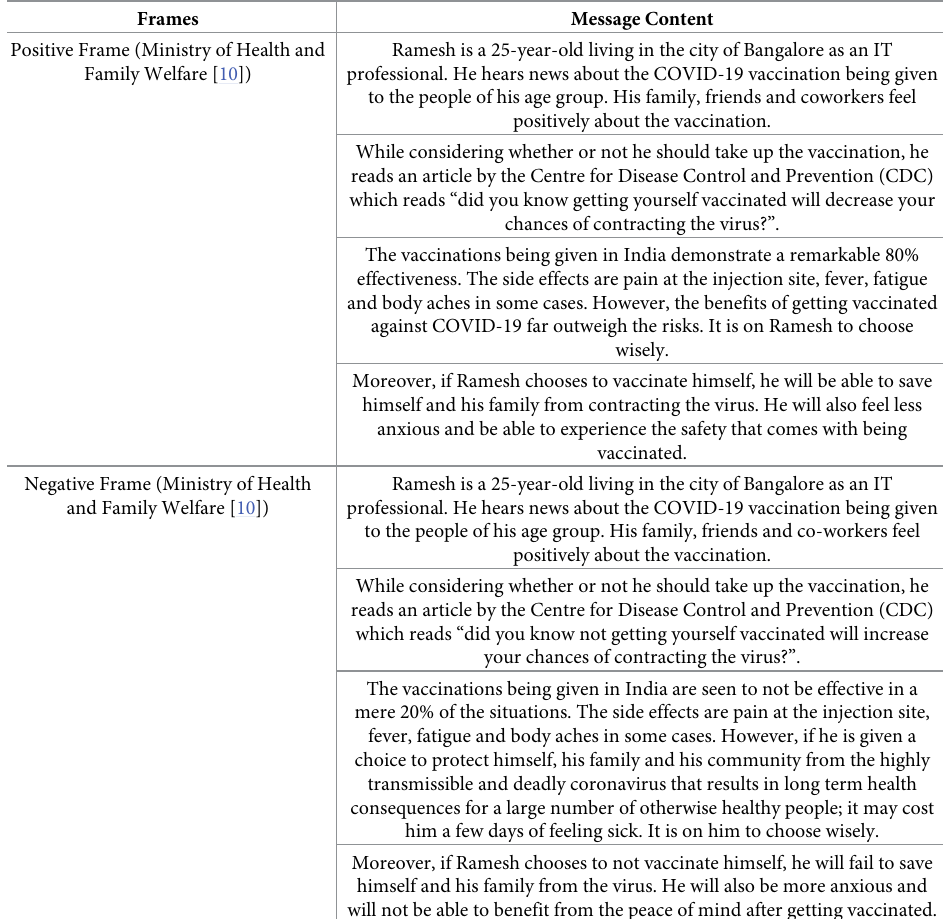
Table 1. Scenarios of positive and negative